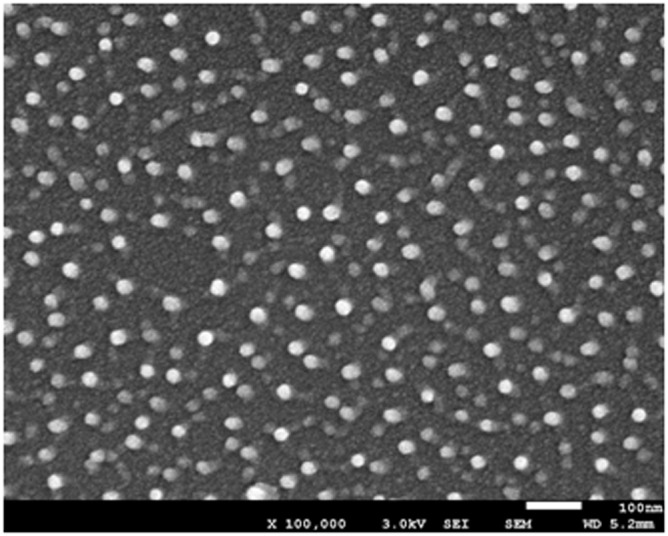
SEM micrographs (100000×) of CaCO3 nanoparticles.